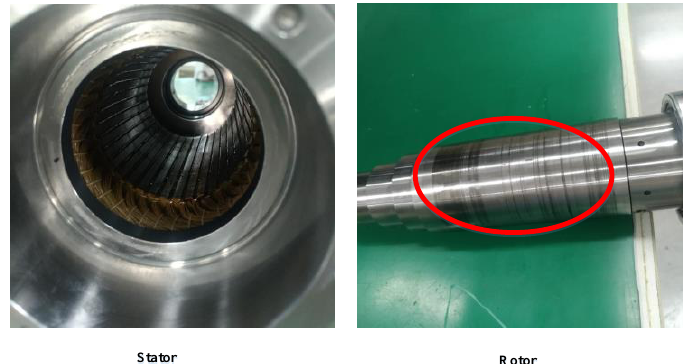
Figure 1. Rotor–stator rub of an induction motor caused by eccentricity